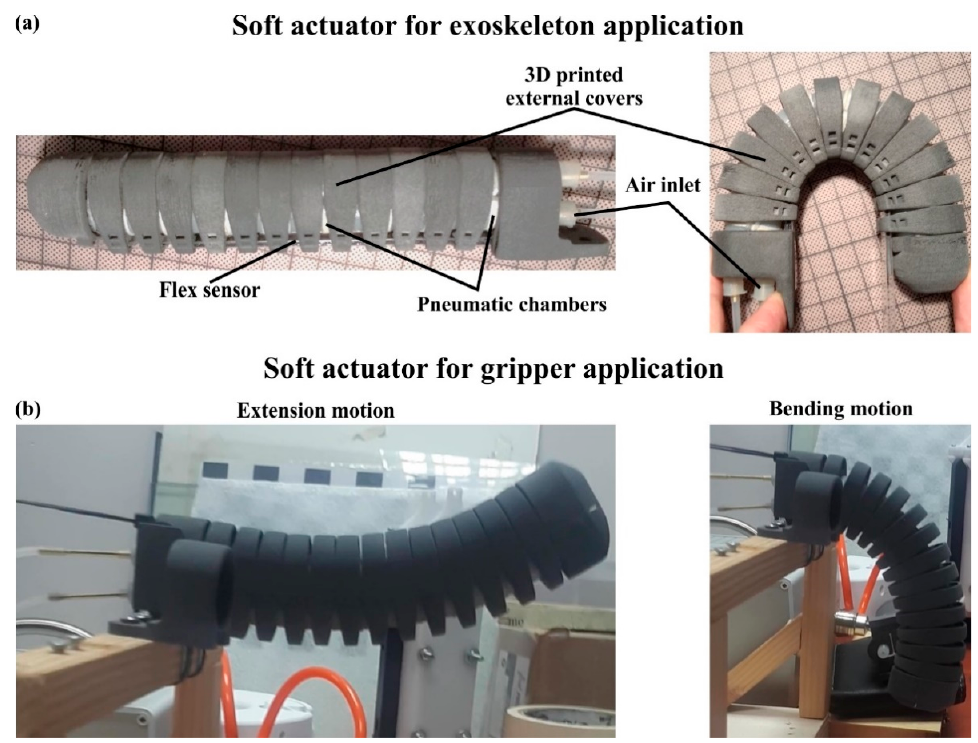
Figure 6. The designed actuator in maximum extension and in maximum bending position for two applications: ( a ) An exoskeleton application; ( b ) Gripper application. applications: ( a ) An exoskeleton application; ( b ) Gripper